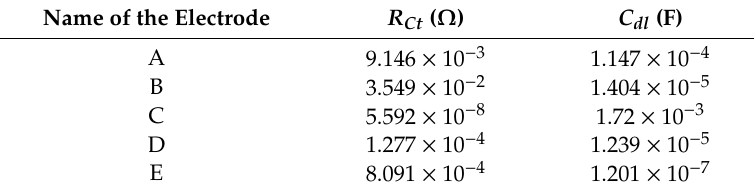
Figure 11. Nyquist plots of samples A, B, C, D and E. Table 3. The EIS fitted circuit parameters of R Ct and C dl values.